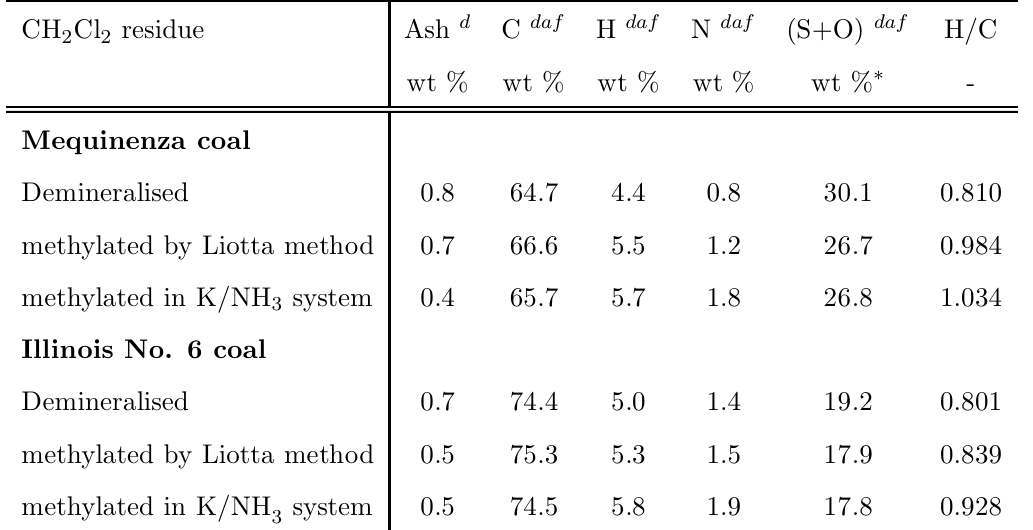
Table 3 Elemental analyses and ash content for CH 2 Cl 2